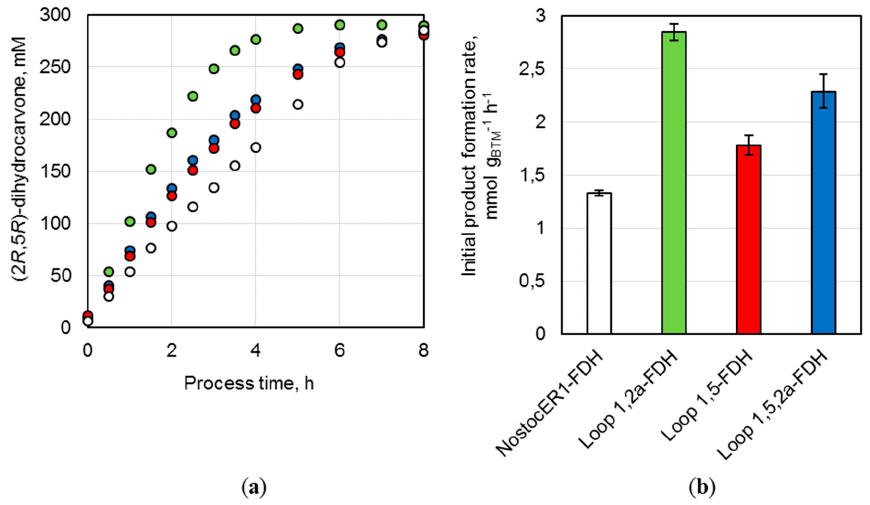
Figure 6. Batch biotransformations in stirred-tank bioreactors on a 0.7 L scale using the recombinant E. coli BL21 (DE3) whole-cell biocatalysts NostocER1-FDH (white), Loop 1,2a-FDH (green), Loop 1,5-FDH (red), and Loop 1,5,2a-FDH (blue). The reactions were performed with 300 mM ( R )-carvon, 450 mM formate, 0.1 mM NAD + , a biocatalyst cell dry weight (CDW) concentration of 30.5–33.7 g CDW L − 1 , and a resin to substrate ratio of 3:1 in sodium phosphate buffer (0.3 M, pH 7.0) at 25 °C. ( a ) (2 R ,5 R )-dihydrocarvone concentration over process time. ( b ) Initial (2 R ,5 R )-dihydrocarvone formation rates of the applied biocatalysts per biomass. All values represent means ± standard deviation of triplicate determinations.